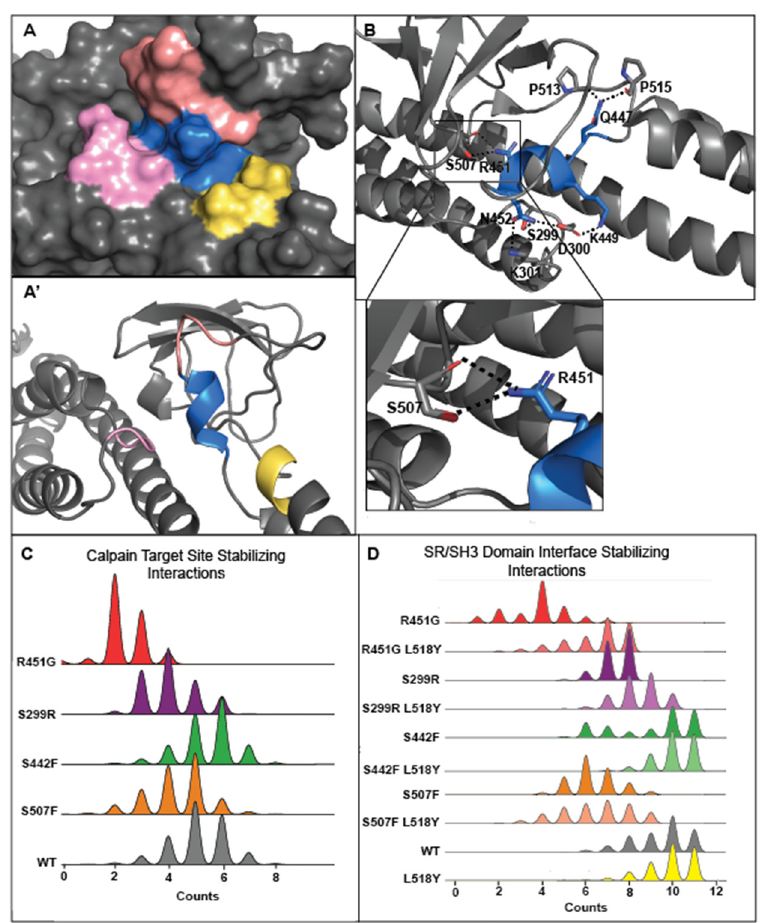
Figure 5. L518Y occludes one of the three faces of the calpain target site. ( A,A’ ) The calpain target site (blue) is solvent-accessible on three sides (salmon, pink, and yellow). L518Y is capable of occluding one of these faces (yellow), however the other two faces (salmon and pink) are left exposed. ( B ) The intramolecular interaction between R451G and S507F is integral for the stability of the target site. ( C ) Intramolecular interactions stabilizing the calpain target site decrease in calpain-sensitive variants. ( D ) Intramolecular interactions stabilizing the SH3/SR4 interface, important in occluding the calpain target site, increase in proximal variants in the presence of L518Y. A complete list of these interactions can be found in tables S1 and S2.